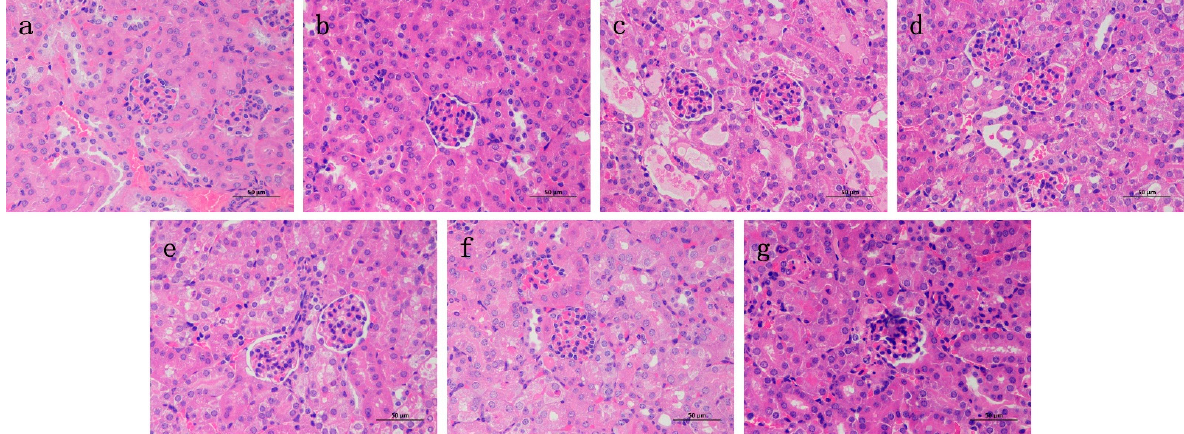
Figure 7. Histological observation of RA on CP-induced AKI in mice and the differences between groups were observed using H&E staining at 400 × magnification. Pathological examination of control group ( a ) mice; ( b ) optimal therapeutic dose of RA (20 mg/kg) given to mice; ( c ) CP (20 mg/kg) challenged mice; ( d – f ) RA (5, 10, 20 mg/kg) treated CP-challenged mice; ( g ) mice were challenged with CP of DEX (4 mg/kg) control treatment drug.